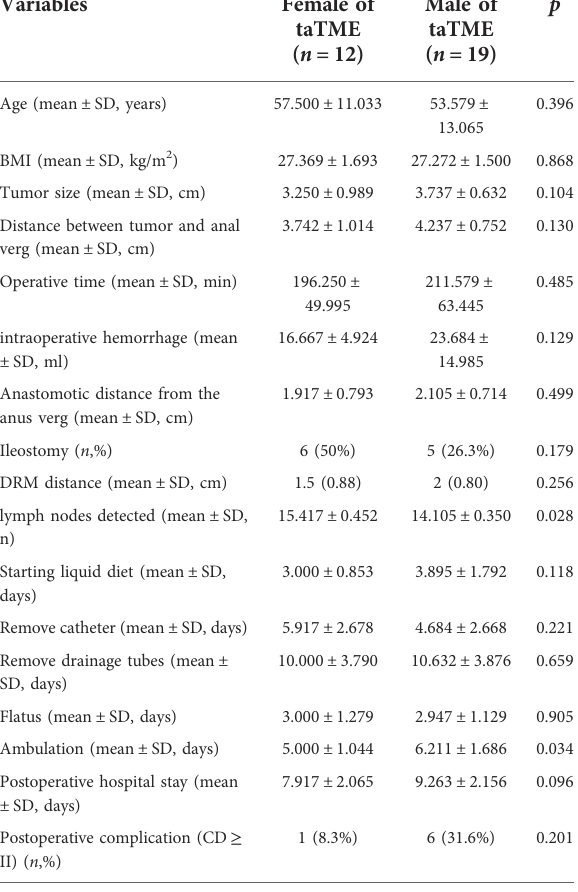
TABLE 4 Comparison of male and female patients in taTME group. TABLE 5 Comparison between male patients in the ISR and taTME